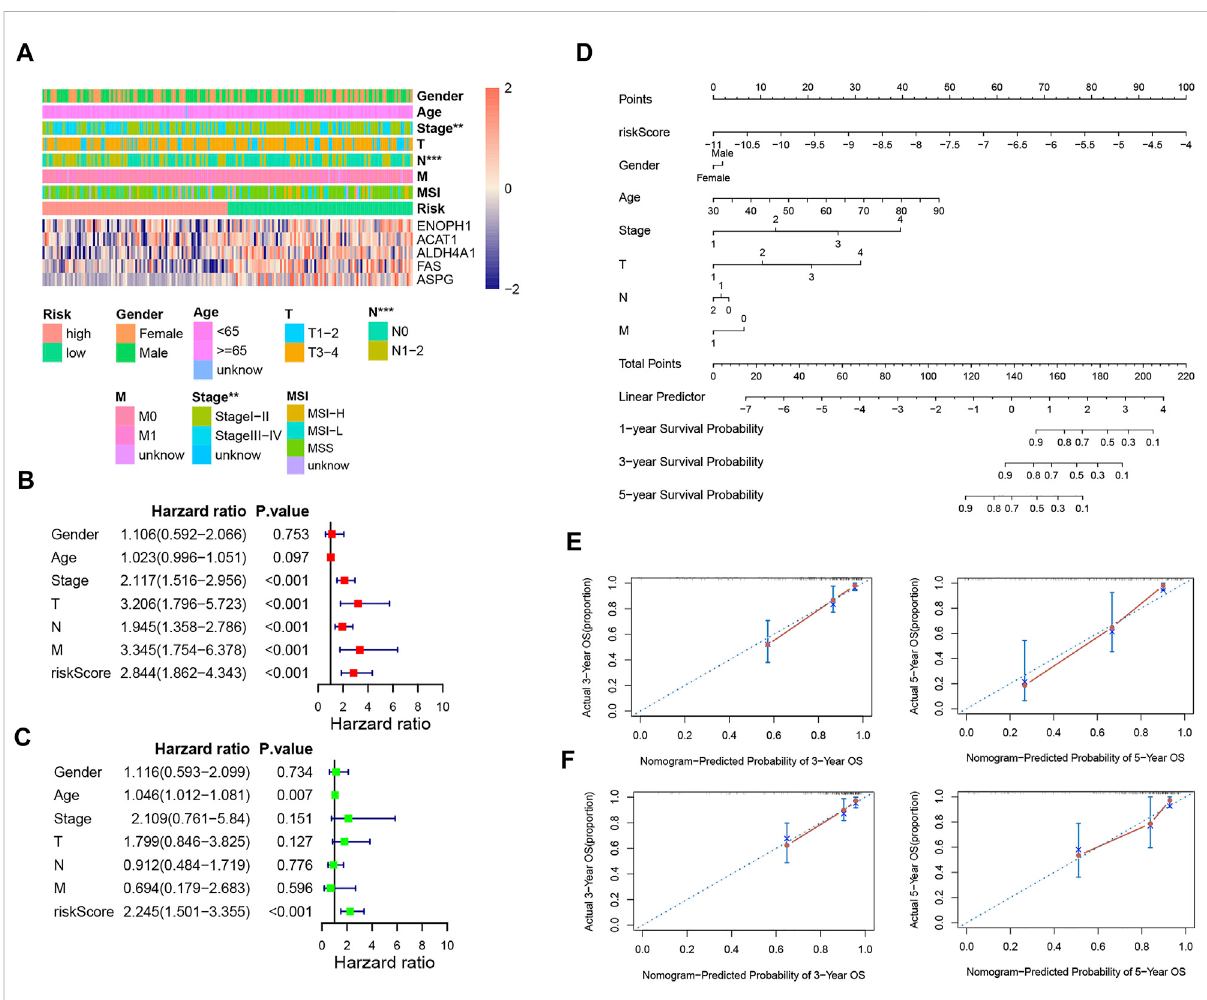
FIGURE 7 Independent prognostic analysis and construction of the prognostic nomogram. (A) Correlation between the risk signature and the clinical factors. (B,C) Forest plots for univariate COX and multivariate COX analyses based on risk score and the clinical factors. (D) Nomogram of COAD patients. (E) Calibration curves for the prediction of 3- and 5-year overall survival of COAD patients in the training set. (F) Calibration curves for the prediction of 3- and 5-year overall survival of COAD patients in the training